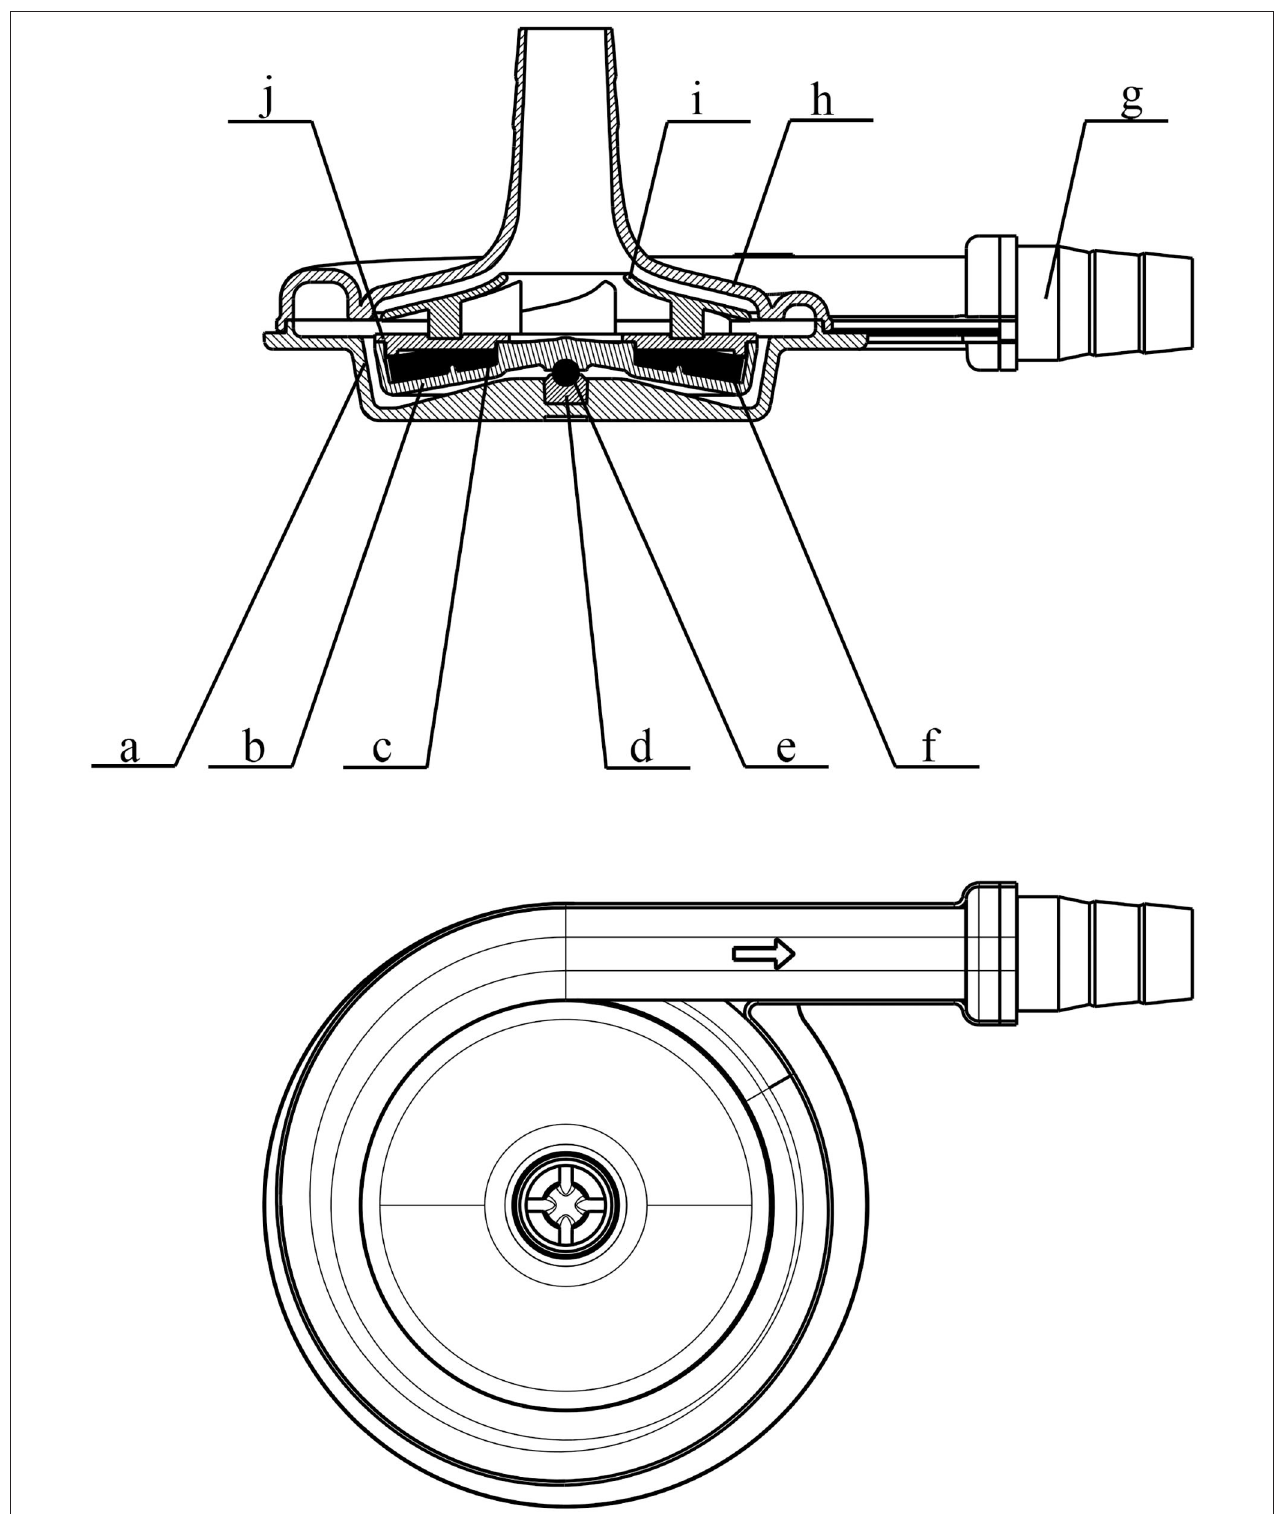
FIGURE 2 | Schematic view of the pump head (STM CP-24 I) of the OASSIST ECMO system. a. the lower case of the volute; b. rotor; c. supporting ring; d. bearing pedestal; e. bearing; f. internal magnet; g. connector; h. the upper case of the volute; i. impeller; j. cap.